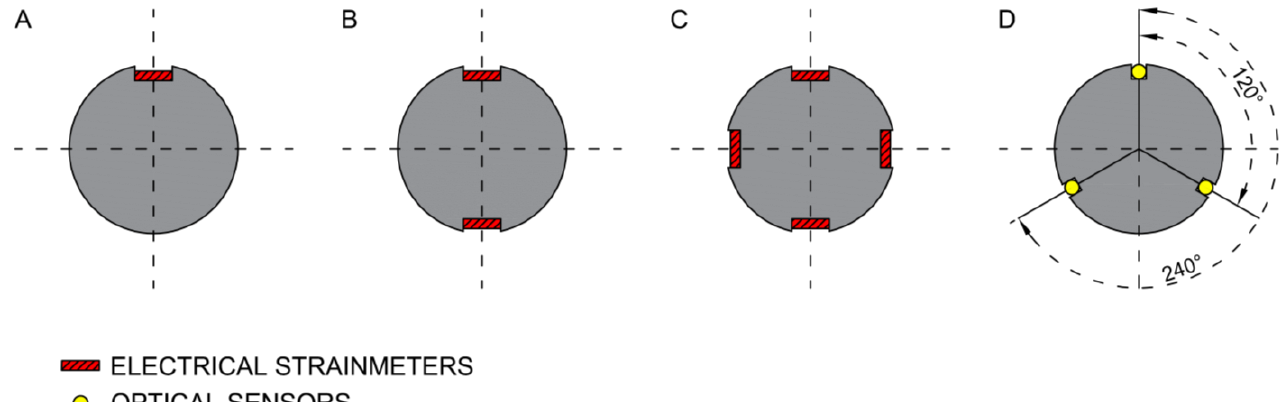
Figure 1. Development of strain sensor systems applied in measurements using instrumented rock